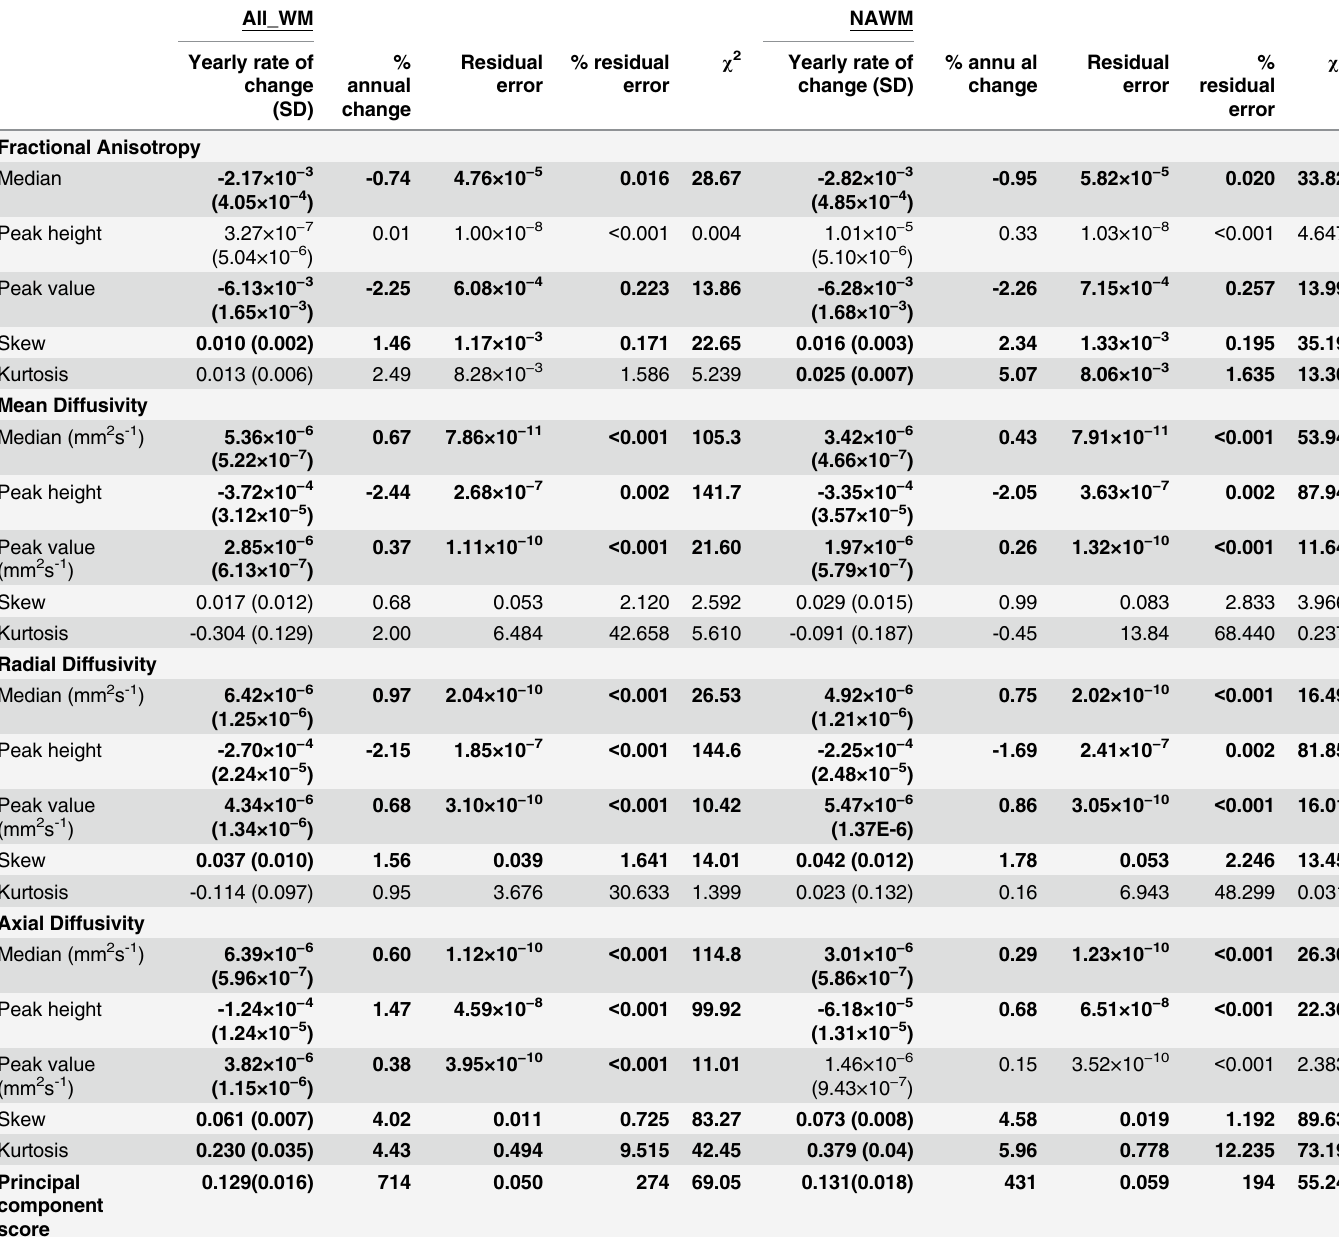
Table 2. DTI parameter progression values calculated through linear mixed effect models.